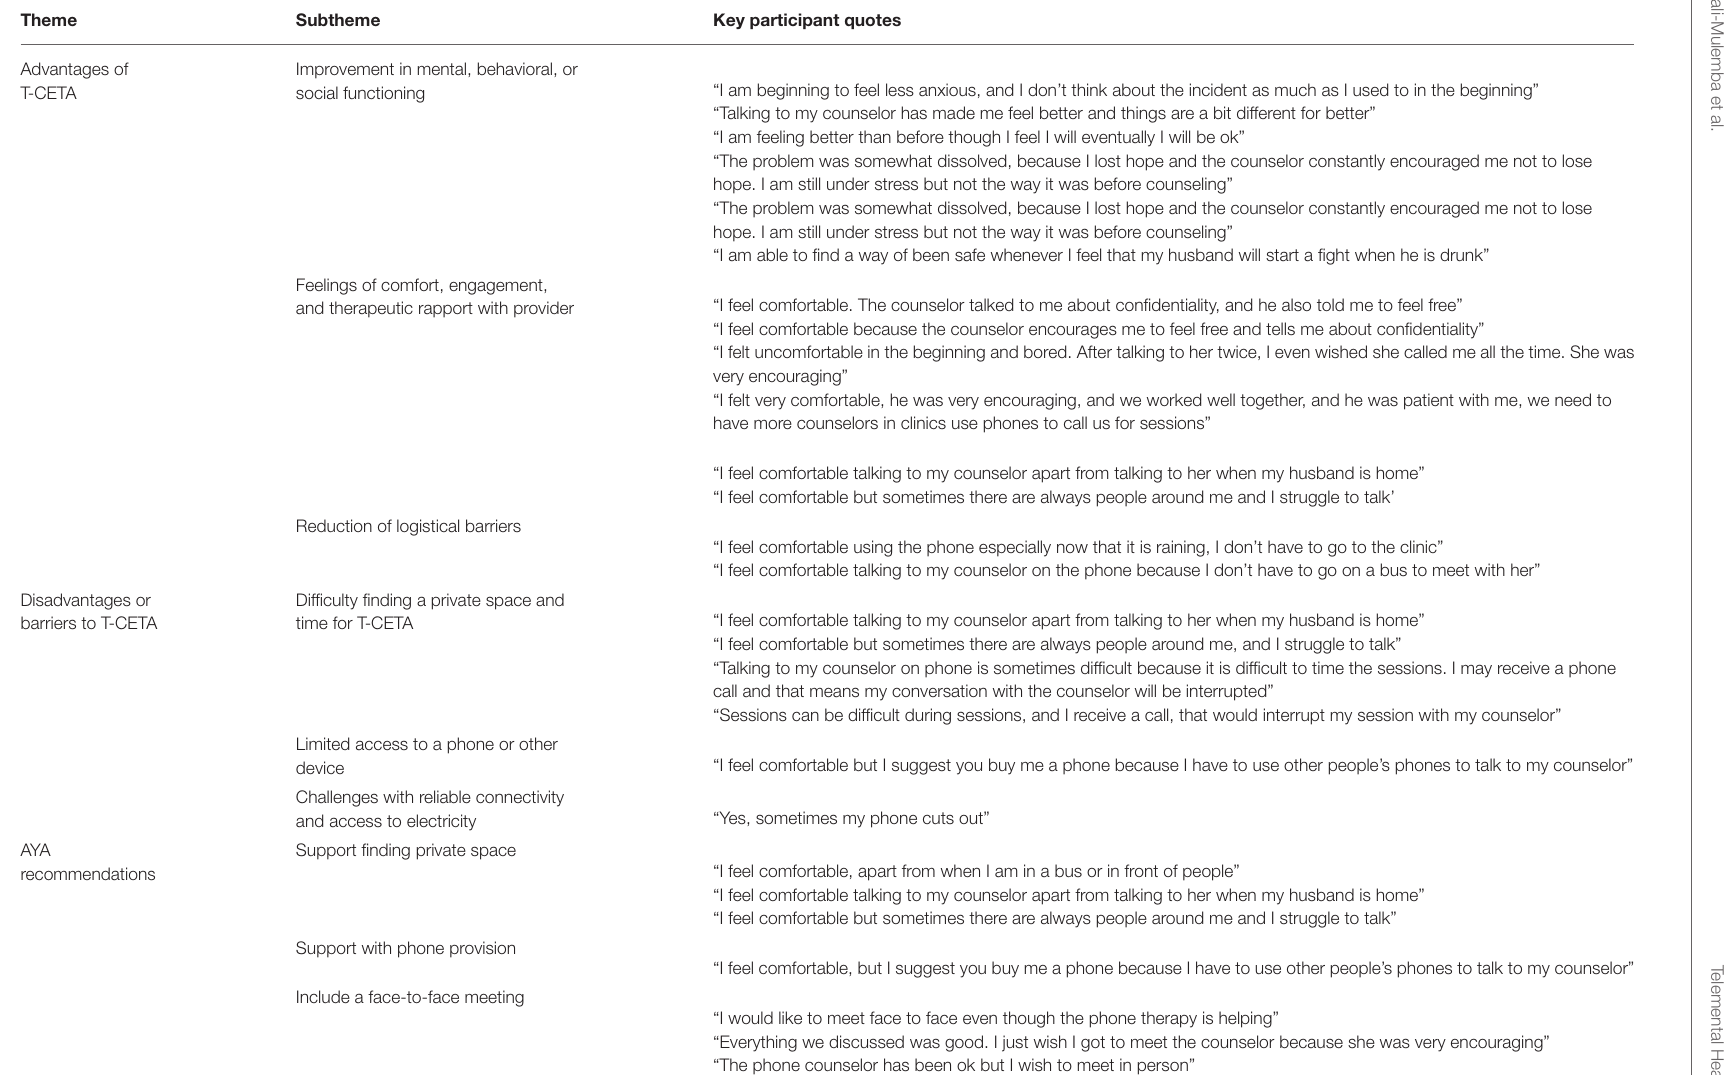
TABLE 1 | AYA reported themes, subthemes, and key quotes. Theme Subtheme Key participant quotes Advantages of